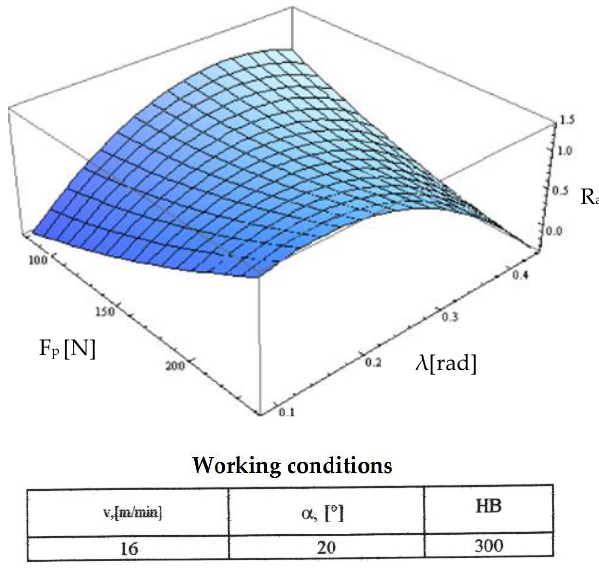
Figure 20. Influence of the inclination angle and radial force on roughness R a.